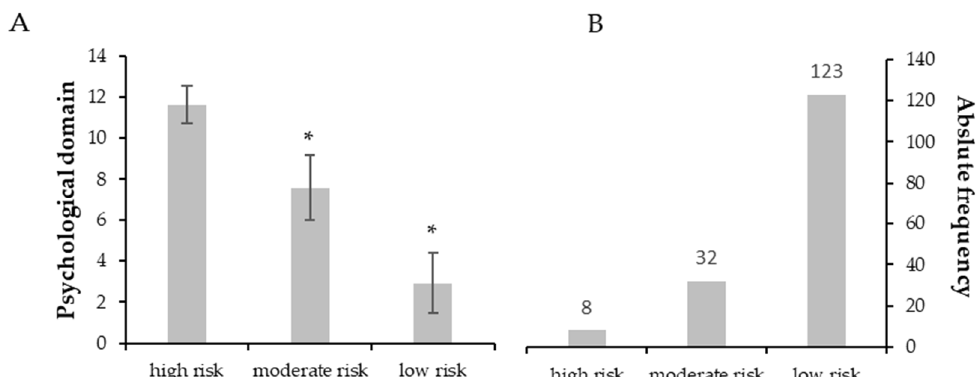
Figure 2. ( A ): Mean ± standard deviation for each risk group of the sensory domain. * p < 0.001 compared to high risk. ( B ): Absolute frequency of older adults in each risk group.